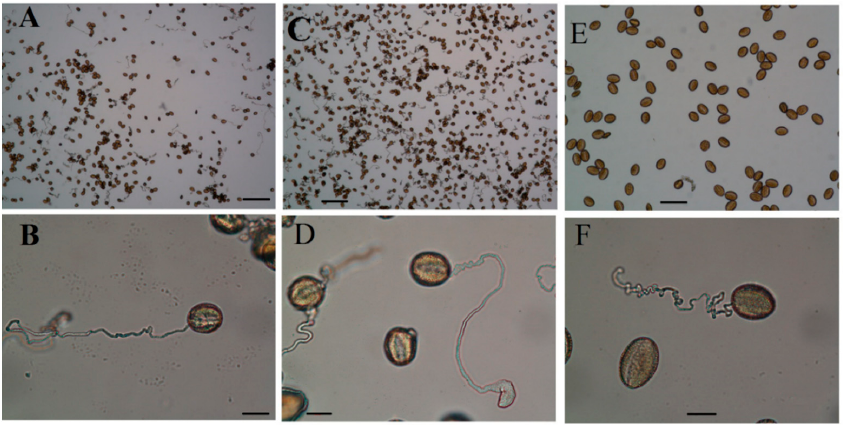
Figure 9. Effect of Cd on in vitro germination of pollen grains in B. napus . Control ( A , B ), 100 µM cadmium-treated sample ( C , D ), 500 µM cadmium-treated sample ( E , F ), pollens are germinated in a culture medium contains polyethylene glycol 4000 (20%) and sucrose (5%). Scale bar: 20 µm.